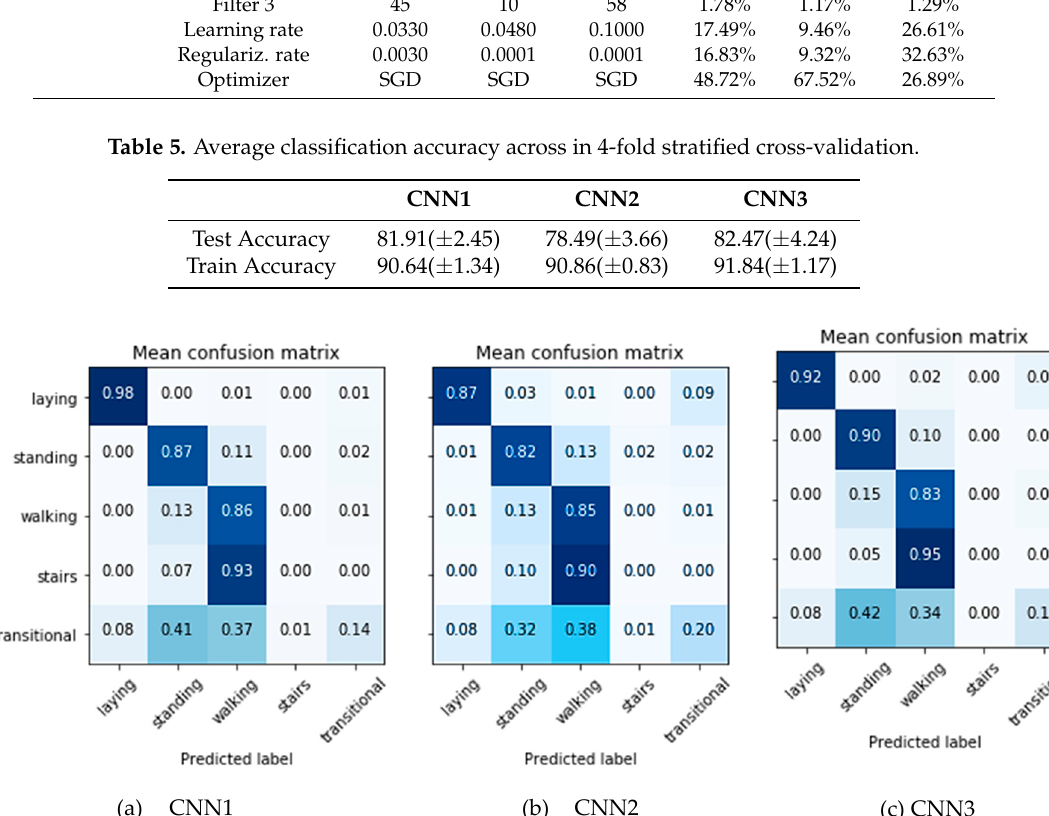
Table 4. Optimized hyper-parameters using SigOpt ( SGD : stochastic gradient descent). Hyper-Parameters